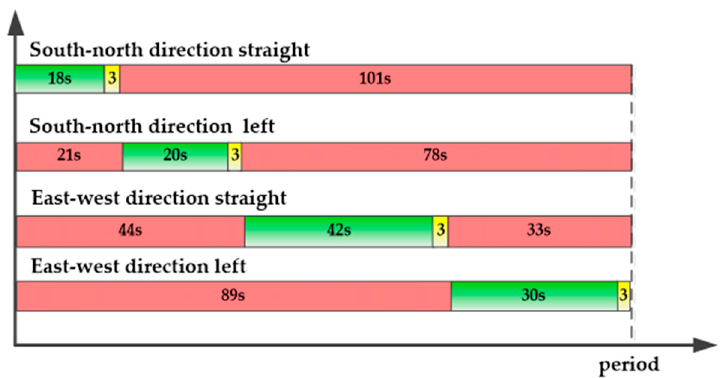
Figure 9. Southbound straight-line adjusted phase time.